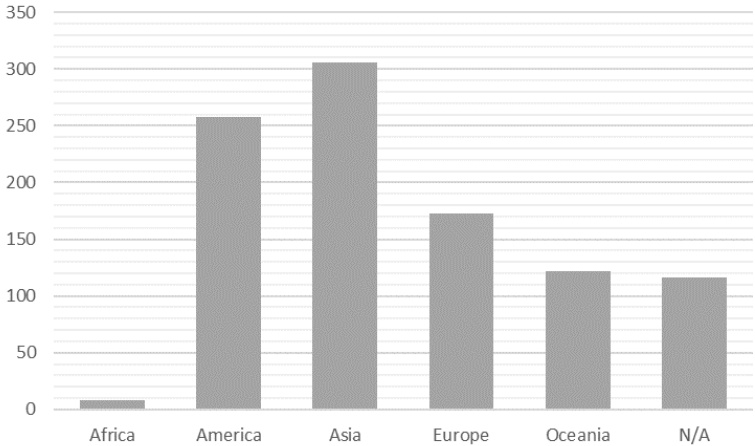
Figure 5. The continent of origin distribution for UGC.